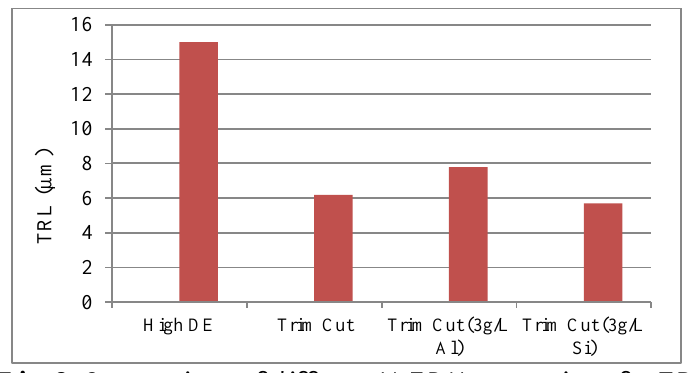
Fig. 8. Comparison of different WEDM operations for TRL